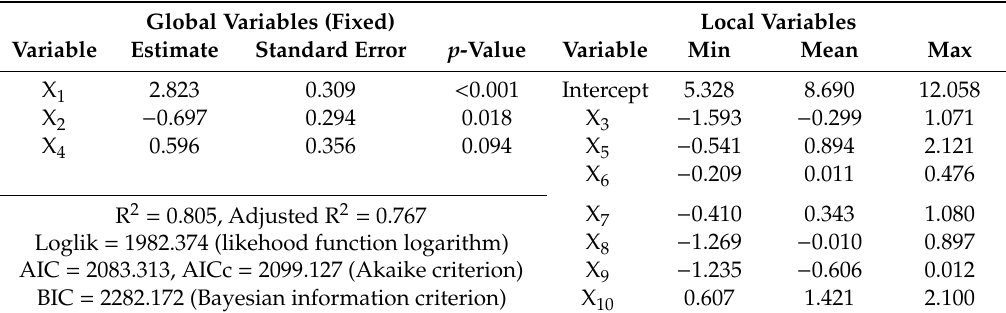
Table 7. Results of the MGWR2 model parameter estimation.